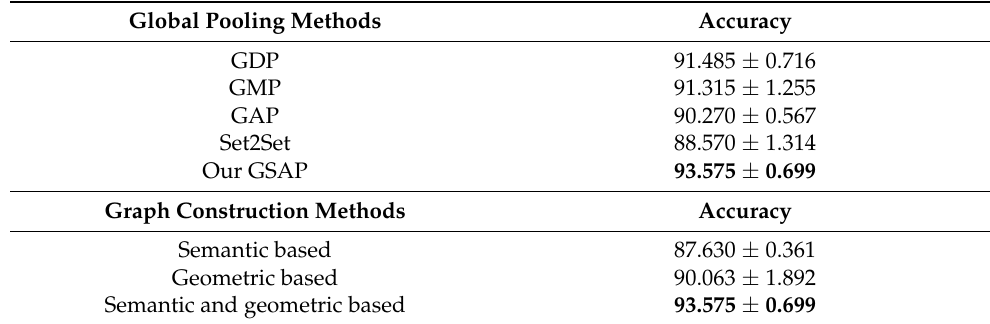
Table 4. The results of different global pooling methods and graph construction methods on Airsim test set. Here, the performances are presented by average accuracy and standard deviation of 10 random seeds of model initialization